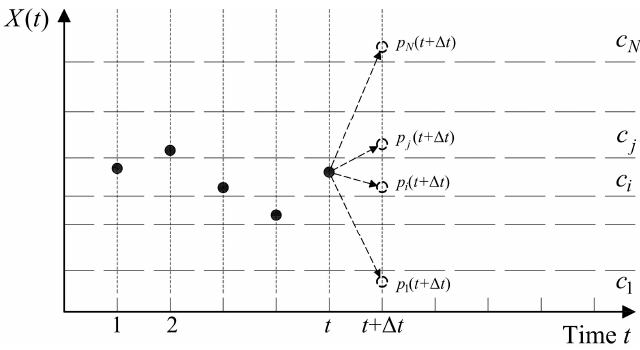
Figure 1. Reference diagram of a Markov process showing the N classes into which the domain of